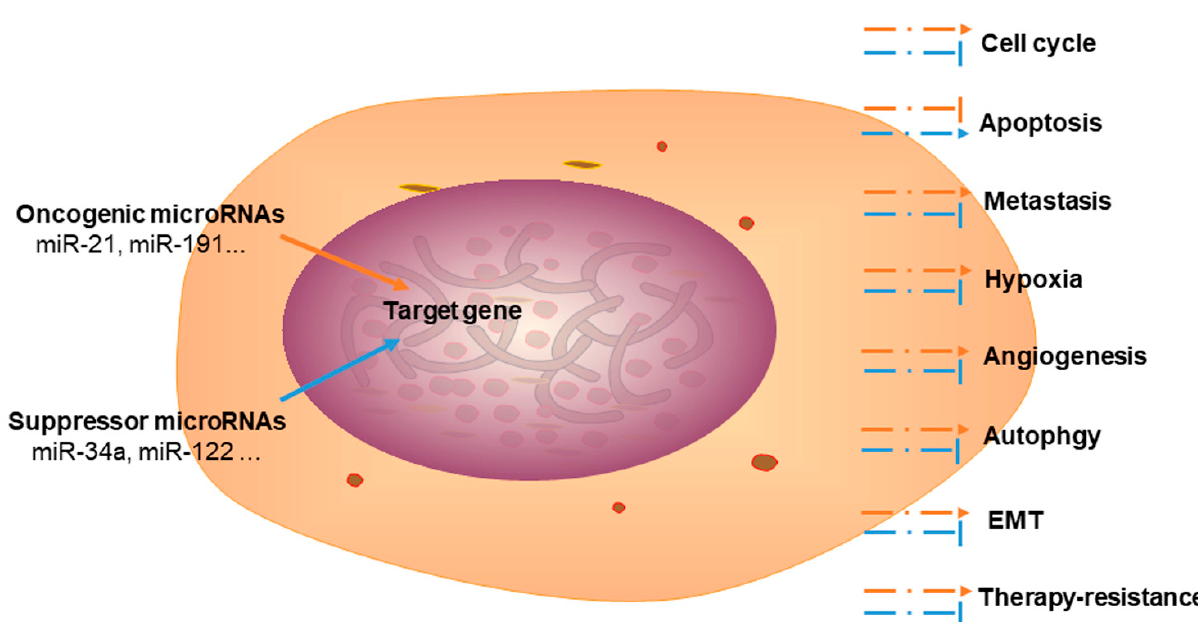
Figure 3. The functions of oncogenic and suppressor microRNAs in cholangiocarcinoma. EMT, epithelial–mesenchymal transition.